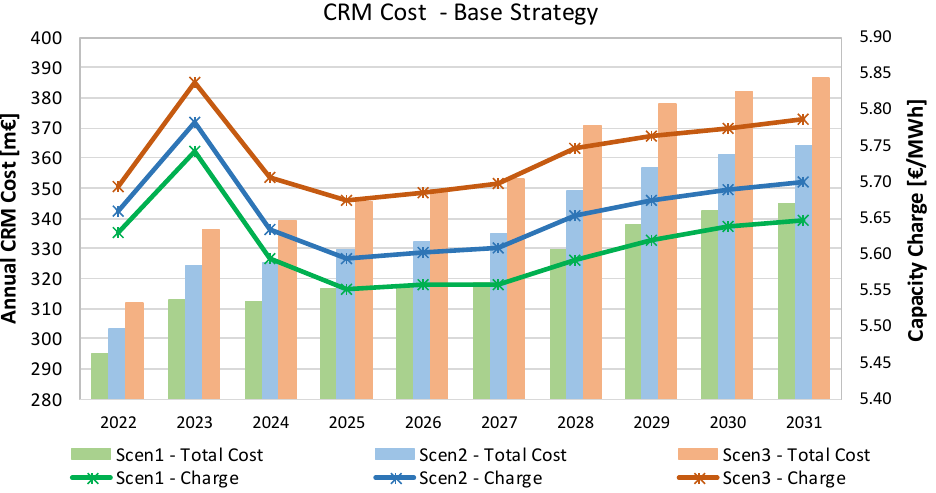
Figure 6. CRM annual cost and capacity charge–Base strategy.